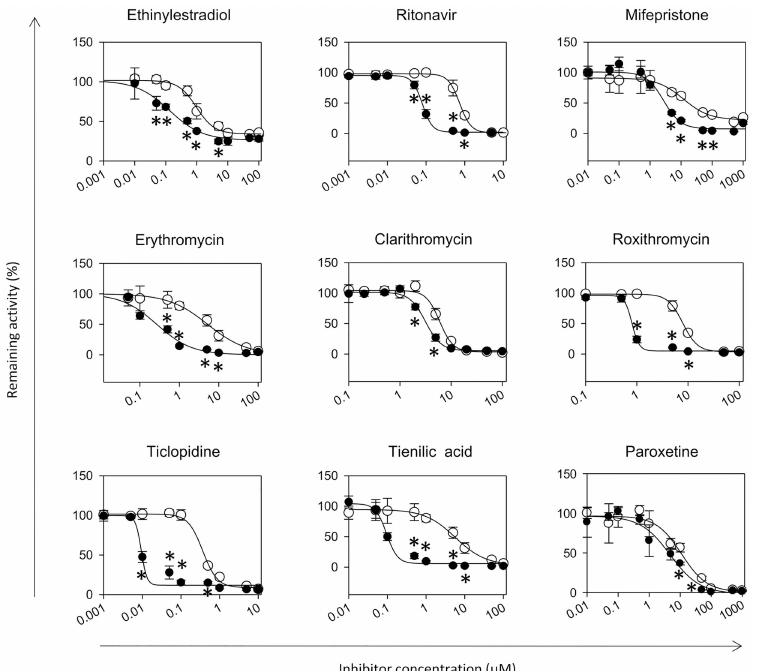
Fig 5. Relationship between relative CYP activity level and inhibitor concentration. RelativeCYP activity was determined as the ratio of CYP-specific luminescence in the presenceof the specific inhibitorsto that in the absenceof the same inhibitor.Open circles represent the values in cultures treated with the inhibitorand the CYP-specific luminescentsubstrate simultaneously [direct inhibition(DI)], and closed circles representthe values in cultures pretreatedwith the inhibitorfor 60 min before the additionof the luminescent substrate (time-dependentinhibition).Values representmeans ± S.D. (n = 4). * P < 0.05 vs each DI group.